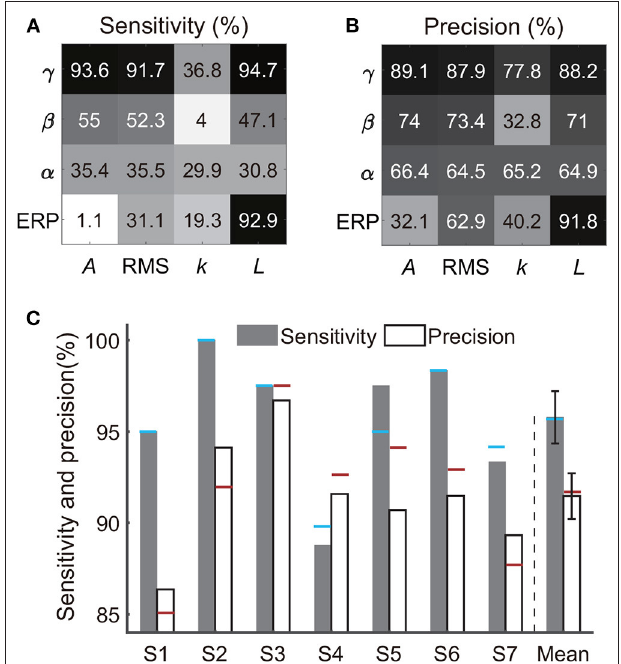
FIGURE 9 | Performances of each single feature type and the four-type feature combination. Panels (A,B) exhibit sensitivities and precisions of 16 types of time-frequency or time-domain features separately, where each type of feature was a subset of the feature combination in Section 2.5 and Figure 4 . The crossover point of the row and column indicates the result of the corresponding feature. Each row represents a type of signal trace, where γ , β , α , and ERP indicate the high-gamma power, beta power, alpha power, and the event-related potential, respectively. Each column represents a type of time-domain feature, where A , RMS, k , and L indicate the amplitude, root mean square, slope, and line-length, respectively. The value represents the mean accuracy across subjects. (C) Sensitivity and precision of the four-type feature combination. Error bars depict the standard error across subjects. The results were compared with the performances of the 16-type feature combination, where the blue horizontal line and the red horizontal line indicate the sensitivity and the precision calculated using the 16-type feature combination, respectively.